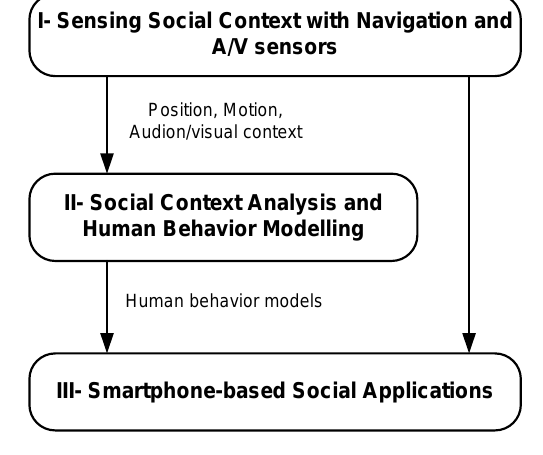
Figure 3. Architecture of a social application.